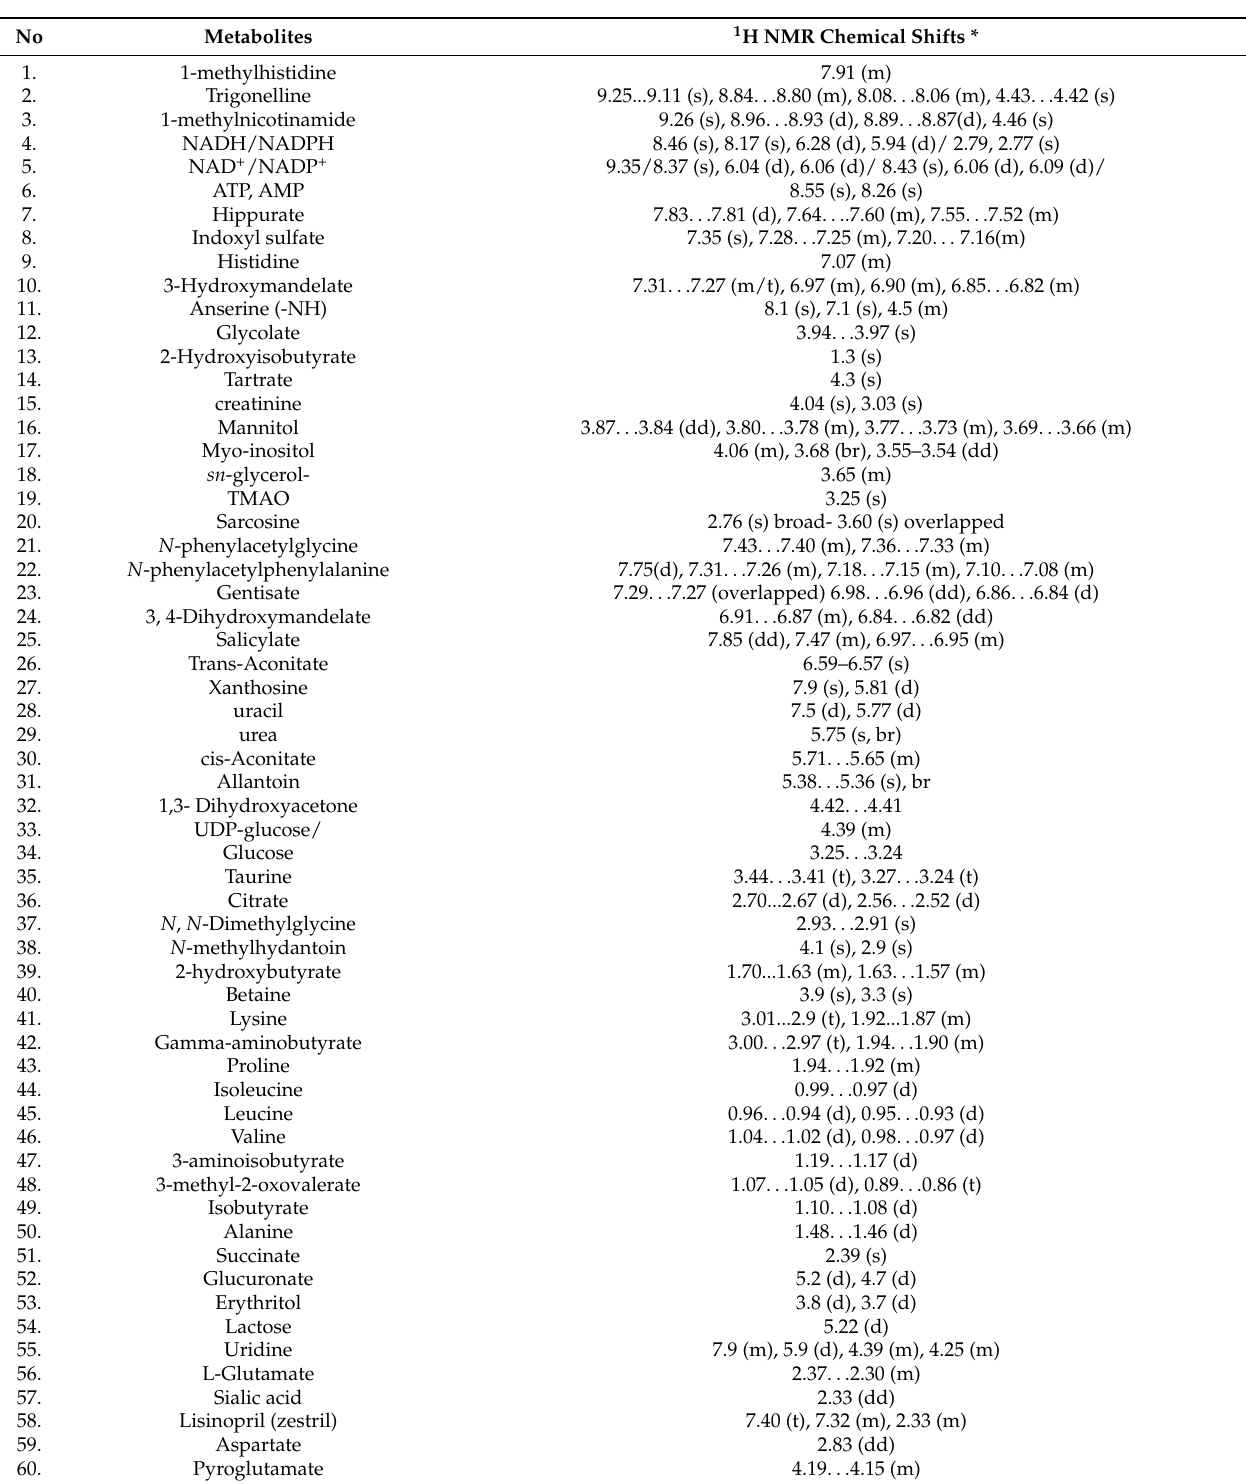
Table 1. 1 H NMR Chemical Shifts and multiplicities of identified urine metabolites in CKD pa- tients. The chemical shifts for each metabolite correspond to the 1 H peaks used for their statistical correspondence with those that contribute to the urinary metabolic